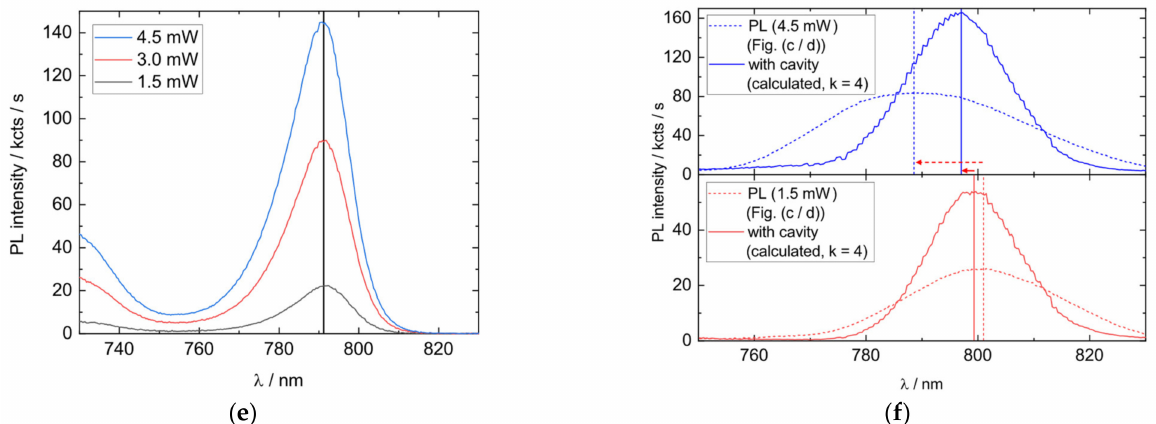
Figure 7. PL power series measurements and corresponding illustrations. ( a ) GaAs QDs with a narrow ensemble and separatable ground-state and excited peaks. ( b ) Illustration of the narrow ensemble structure by fitting Gaussian peaks, representing s-, p-, d- and f-states. The single-peak FWHM for the energy-states is in the range of 20 meV to 27 meV. ( c ) PL power series of GaAs QDs inseparable energy states caused by a broader ensemble. Nevertheless, higher excitation power shifts the peak maximum to shorter wavelengths, which is caused by shell filling and thus brighter excited peaks. ( d ). Illustration of the spectral composition in ( c ), by fitting Gaussian peaks to s- and p-states. The ensemble FHWM is in the range of 60 meV to 66 meV. ( e ) PL power series with cavity dominated spectrum. The PL peak shows no significant position change with higher excitation, as the cavity dip does not respond to higher excitation but strongly influences PL emission. ( f ) Illustration of the spectral change in ( e ) by combining the PL-spectrum from ( c ) with empirical Equation (1), where the measured reflection spectrum of the photonic sample is used (comp. Figure 6b). The peaks are narrowed and the peak position shifts by changing the laser excitation power only 19% compared to the raw PL spectral change. Vertical lines serve as a guide-to-the-eye, highlighting the position of peak